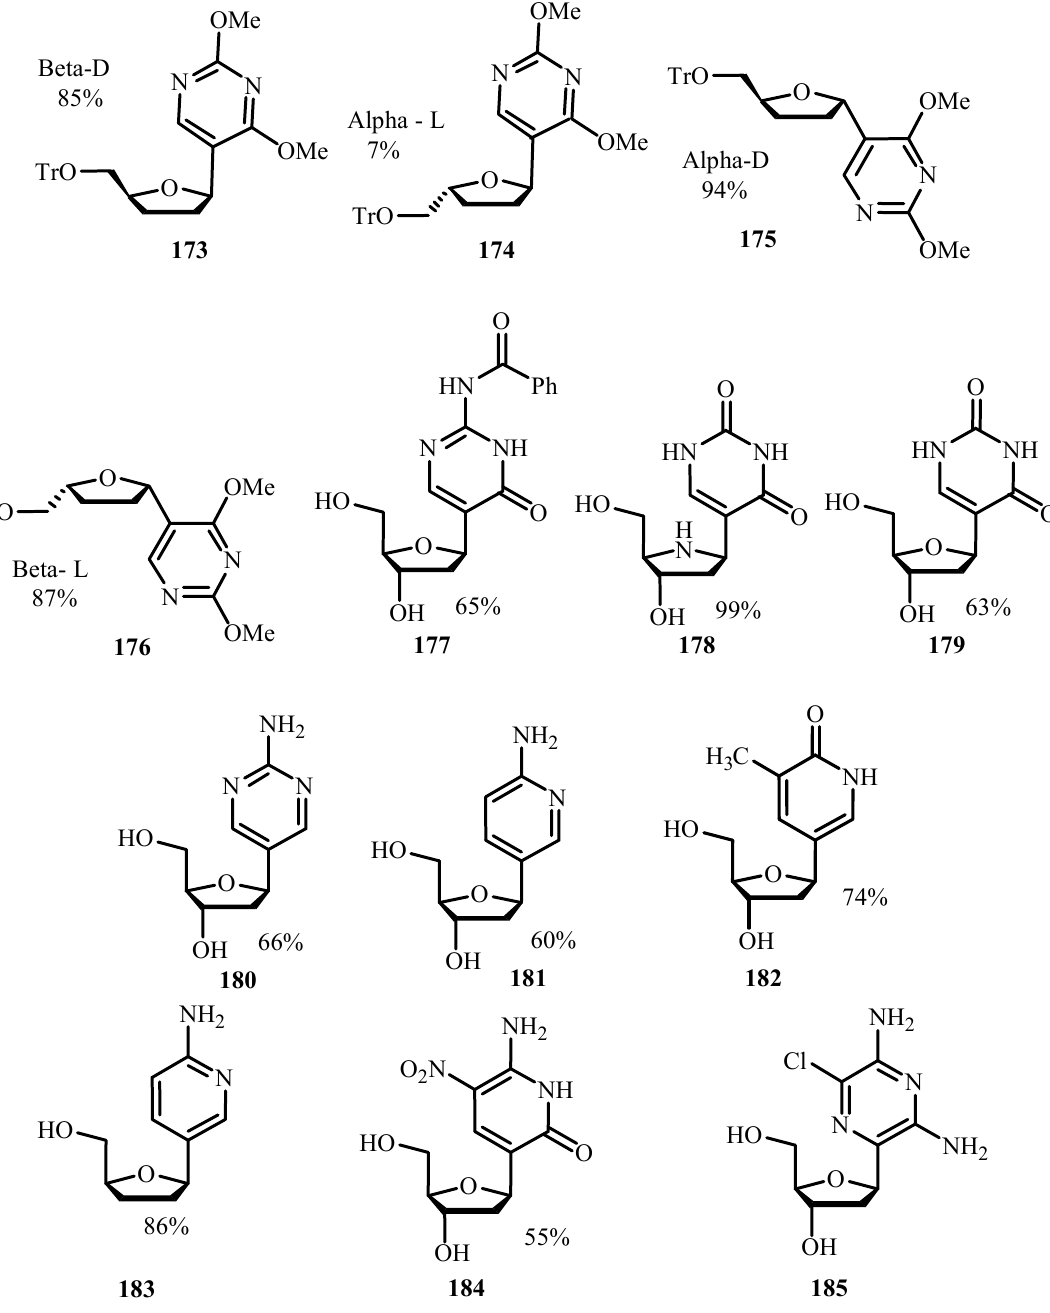
Figure 26. Glycosides synthesized via Heck reaction reviewed by Wellington and Benner [92].